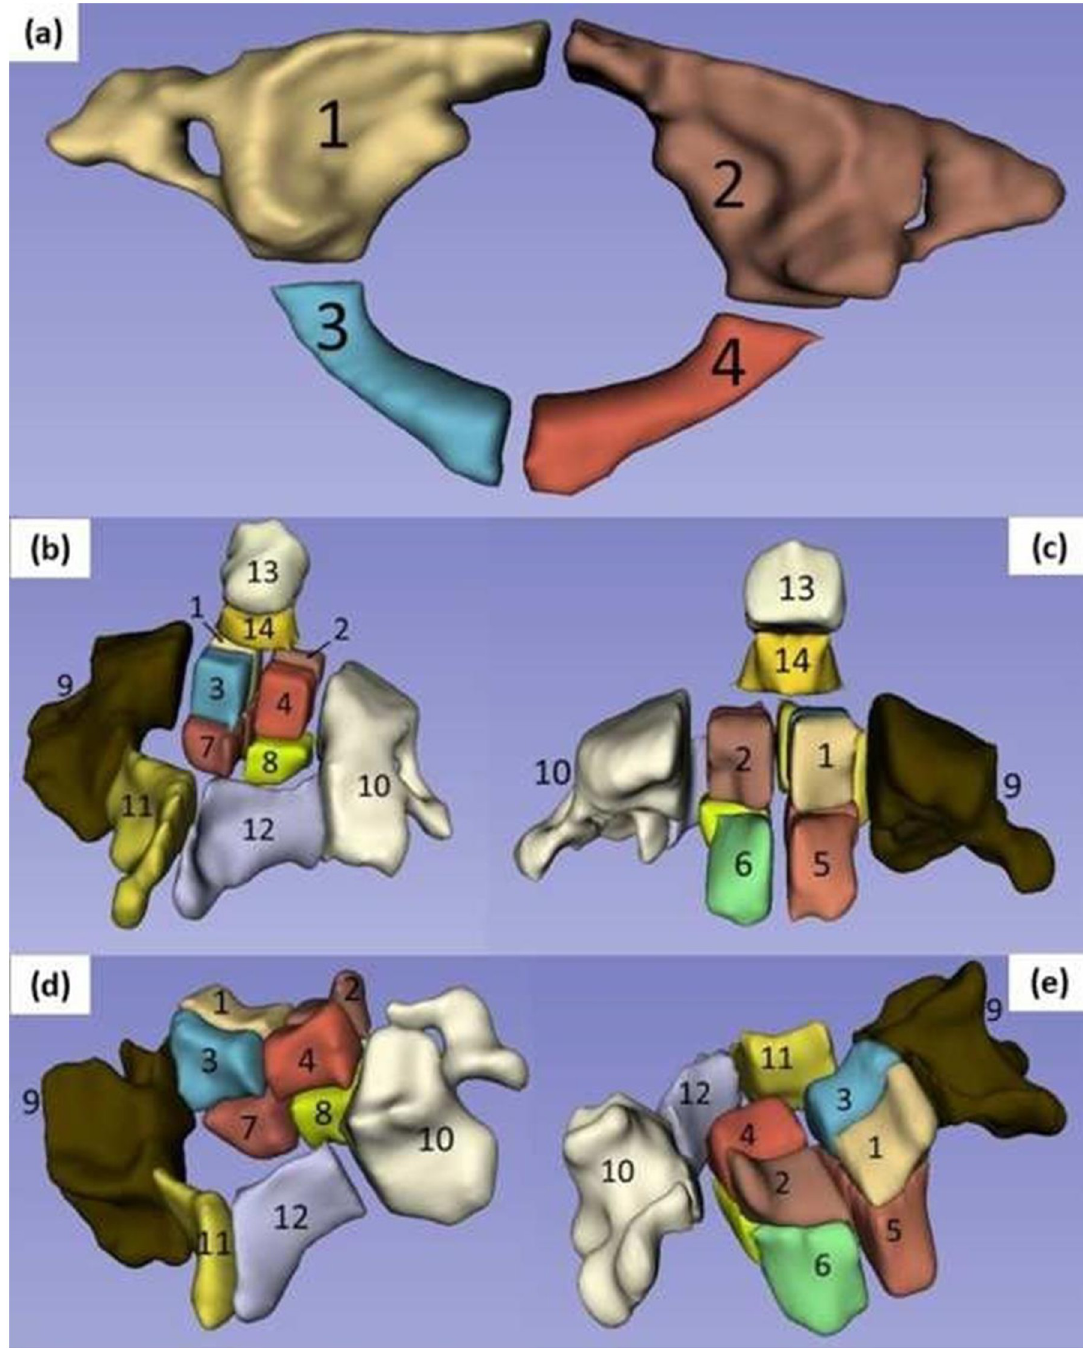
Fig 2. Identification of bone regions for each vertebral level: (a) bone regions of C1; (b) bone regions of C2, posterior view; (c) bone regions of C2, anterior view; (d) bone regions of C3-5, posterior view; (e) bone regions of C3-5, anterior view.